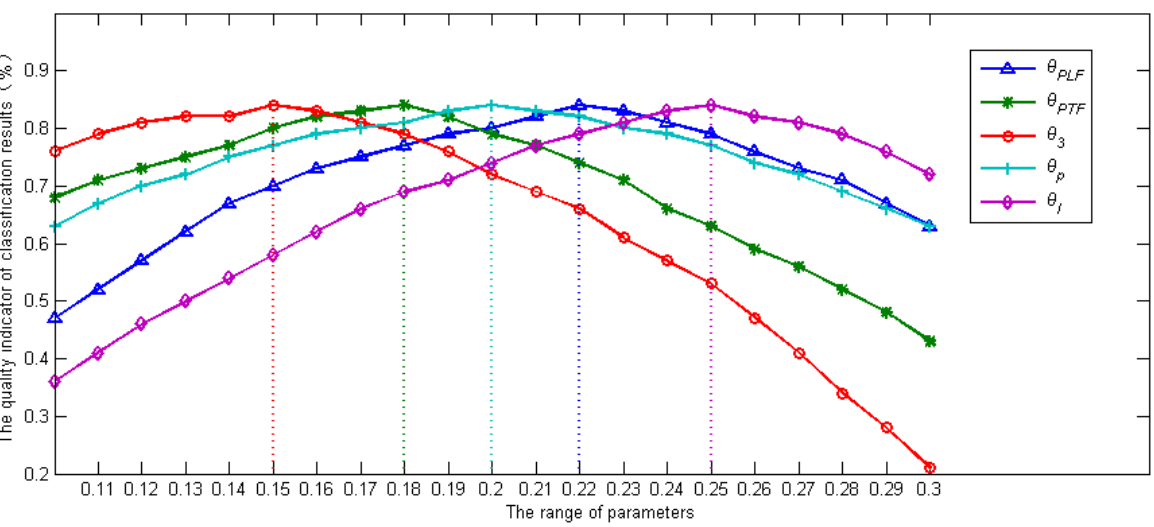
Figure 6: The classification accuracy with different parameters, with only one parameter is changing while the others are